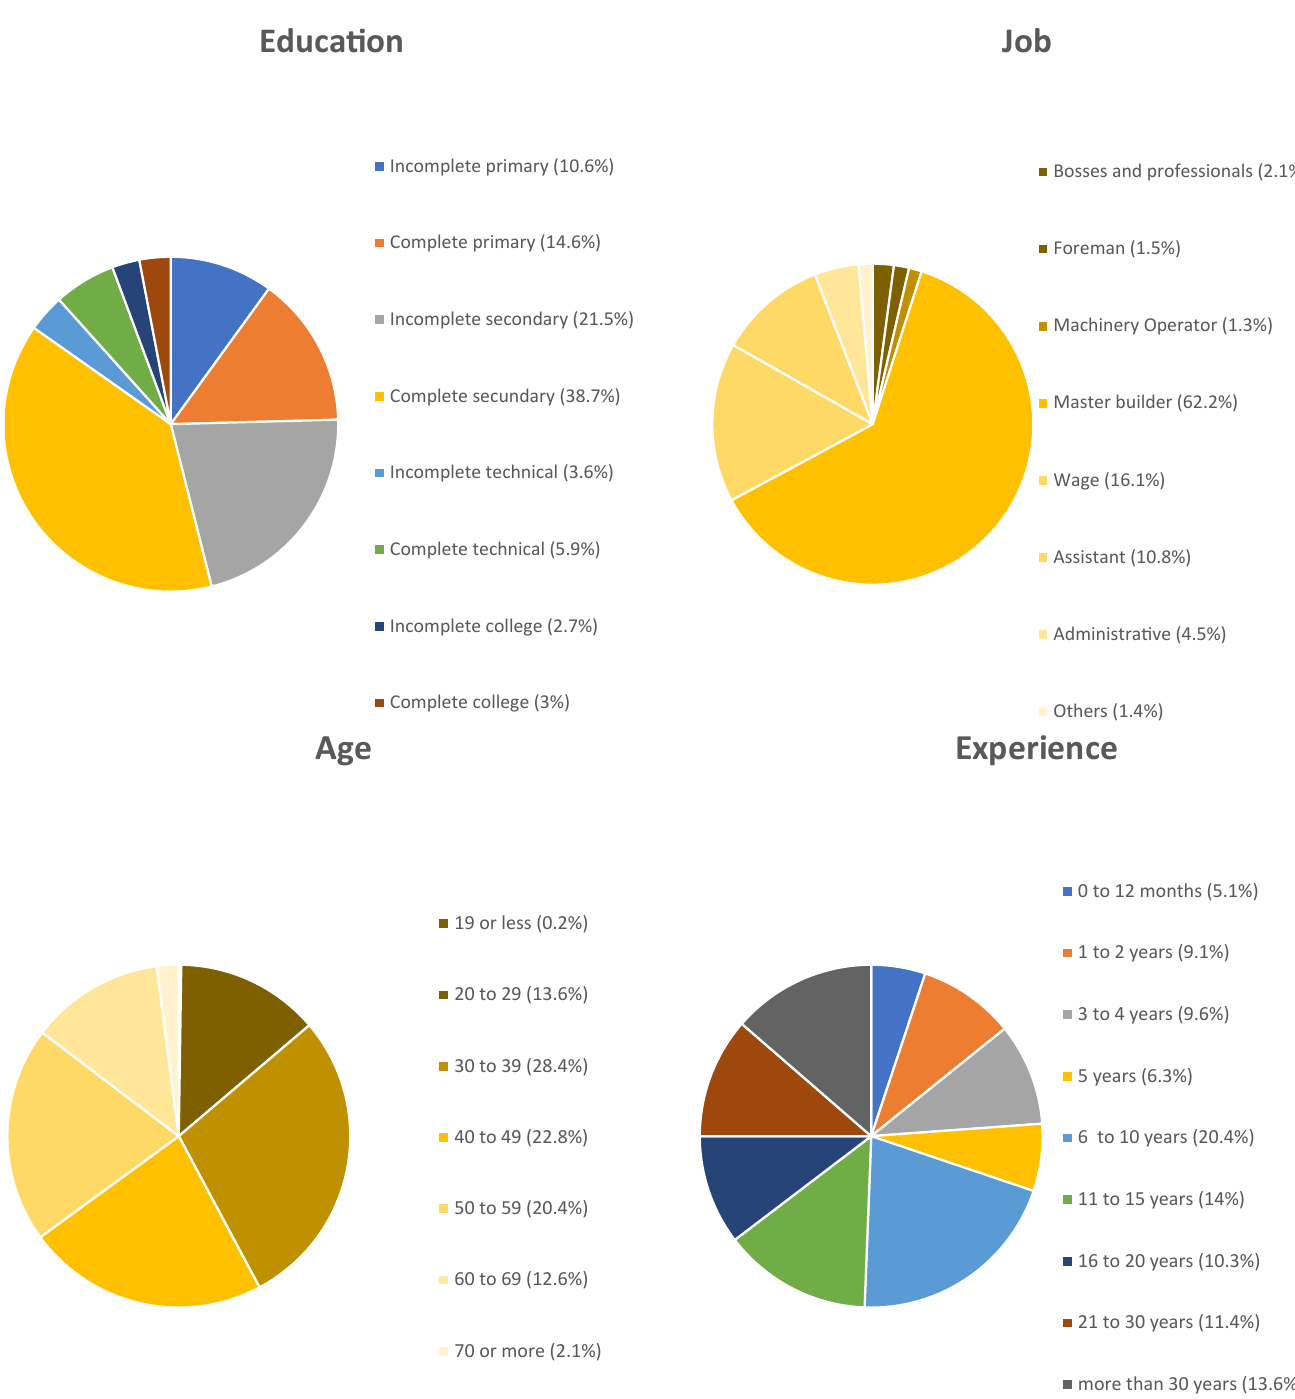
Figure 1. Pie charts of the variables education, occupation, age and experience of unemployed workers surveyed. Analo- gously to the US education system, primary and secondary education correspond to basic and secondary,